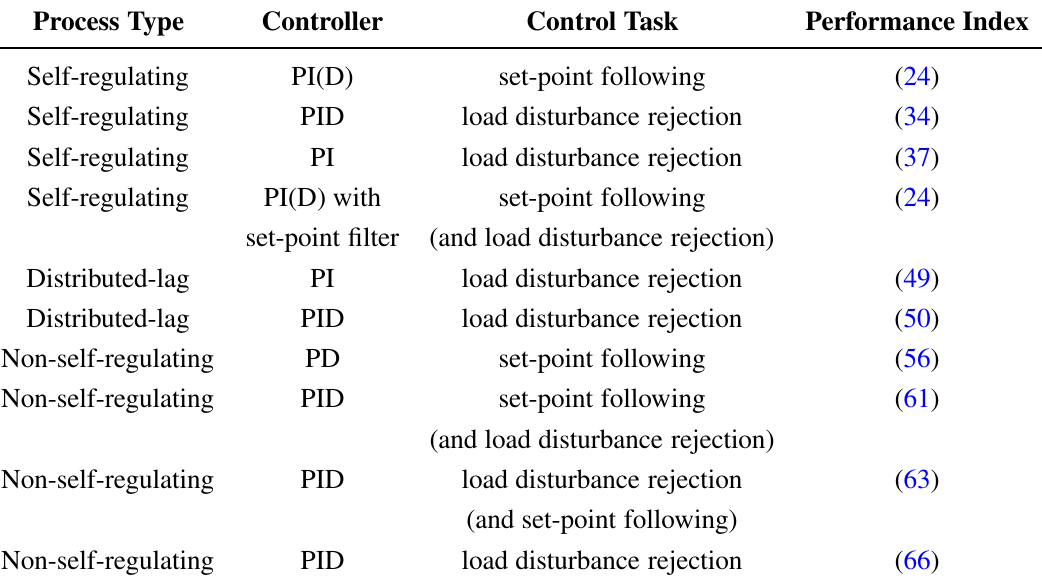
Table 1. Summary of the performance indices for the different kinds of processes and control